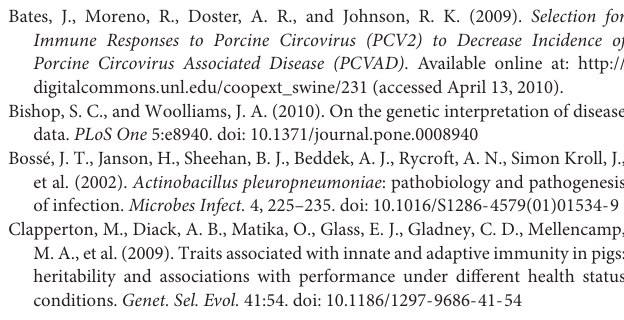
Supplementary Figure 1 | Genetic (lower triangular) and phenotypic (upper triangular) correlation between all traits: influenza A virus (IAV), porcine circovirus type 2 (PCV2), Mycoplasma hyopneumoniae (MH), Actinobacillus pleuropneumoniae (APP), and porcine respiratory and reproductive syndrome (PRRS) at Entry (A), Post-acclimation (B), Parity 1 (C), and Parity 2 (D). The values between parenthesis correspond to the standard error of the correlation. The blue color corresponds to positive correlation, the red to negative correlation, and the gray indicate the lack of convergence of the model. Supplementary Table 1 | Percentage of total genetic variance explained for by markers (% TGVM) within a 1-Mb window for traits with significant QTLs using a threshold of 1% TGVM and posterior probability of inclusion (PPI) of 0.70 (before SNP selection). The SNP explaining most of the TGVM within a window was selected and the % TGVM explained by the SNP (% TGVM-SNP) was also estimated (after SNP selection). Supplementary Table 2 | Accuracies of genomic